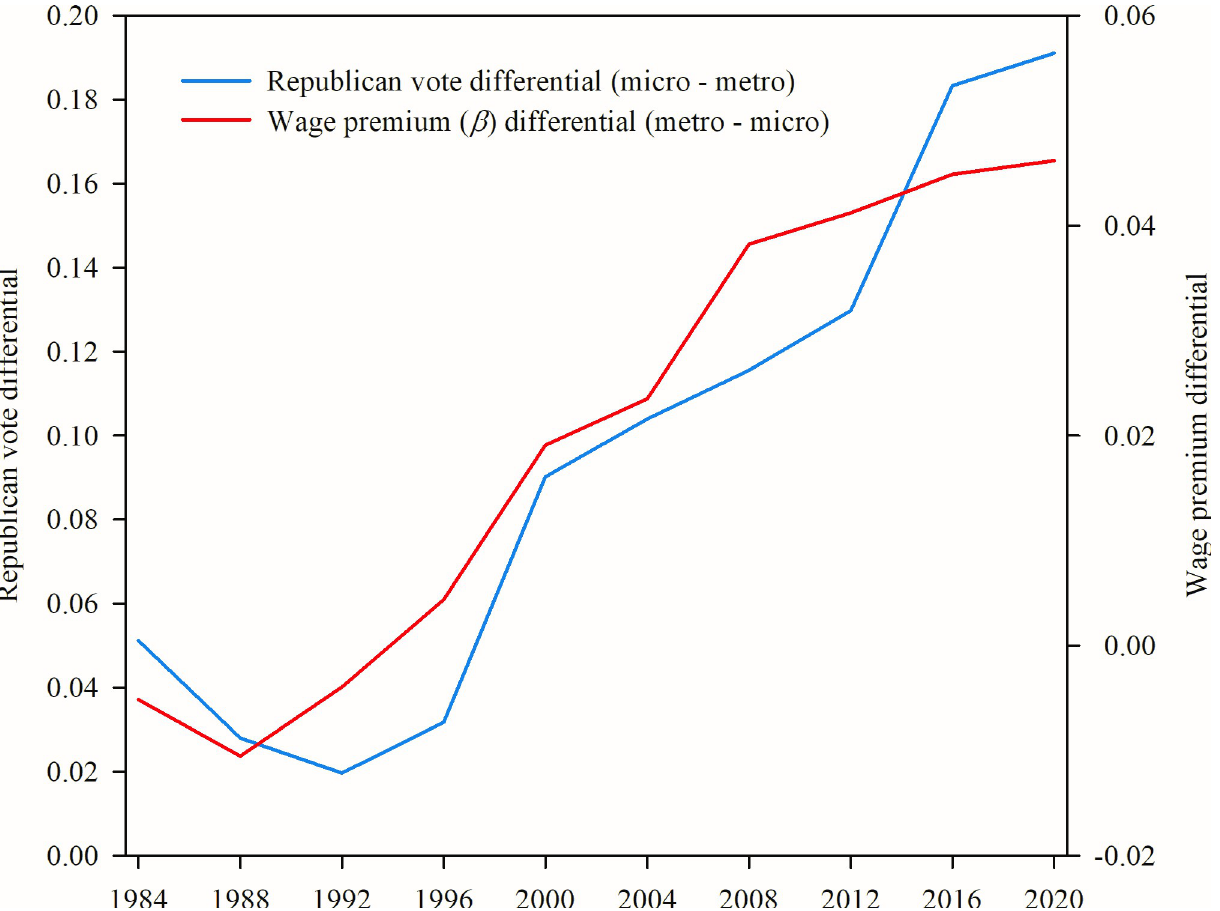
Fig 4. Metropolitan-micropolitan divergence of wage premium and presidential voting behavior. Here we plot only the differences between two attributes of metropolitan and micropolitan areas during presidential election years 1984–2020. The red line plots the metropolitan scaling coefficients minus the micropolitan scaling coefficients from Fig 1. The blue line plots, for presidential elections, the percentage of total votes in micropolitan areas that were for the Republican candidate minus the same percentage in metropolitan areas. As the gap between metropolitan and micropolitan wage premiums has increased since the late 1990s, so too has the difference in percent of votes for the Republican presidential candidate (N = 10, R2 = 0.91, p < 0.001).